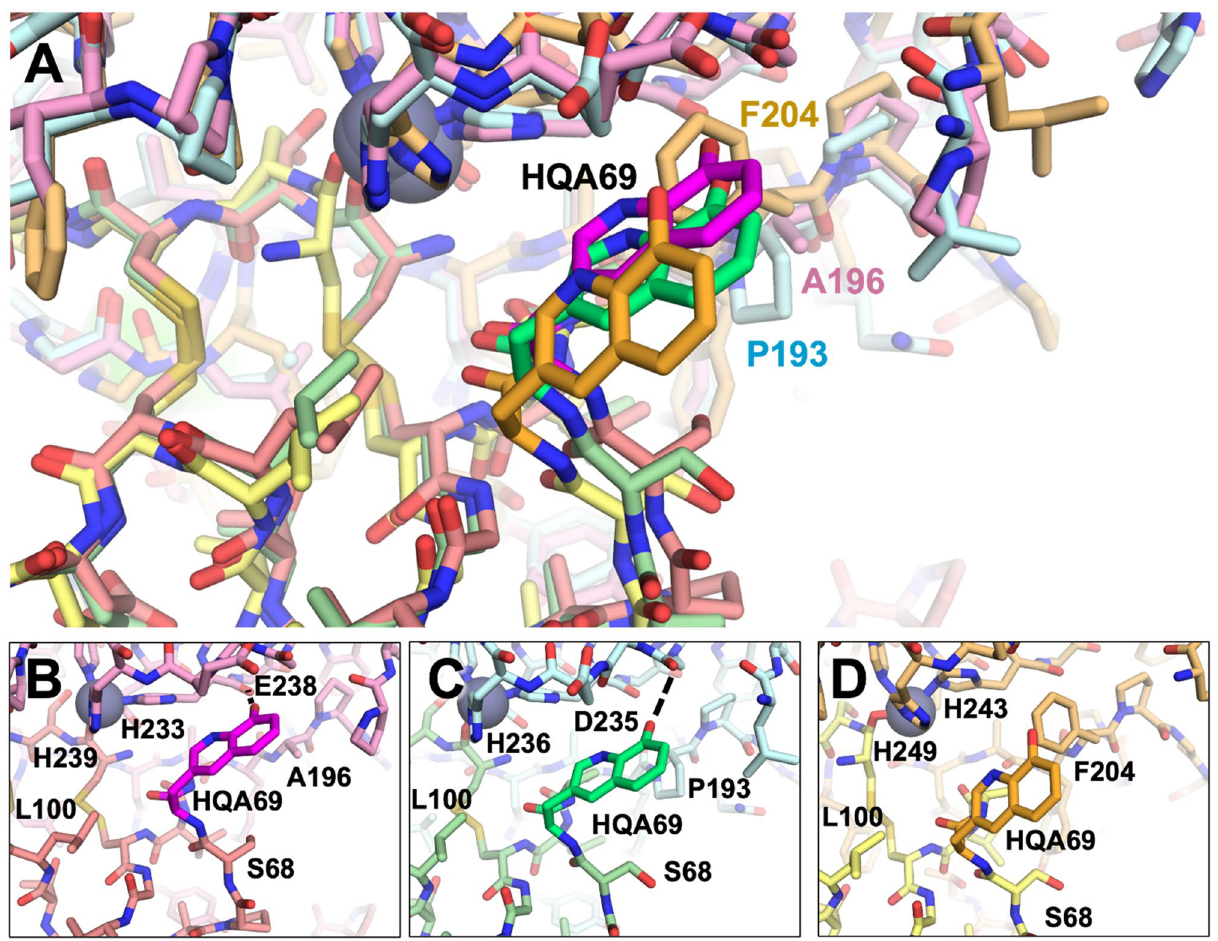
Figure 7. Structural comparison of MMP/N-TIMP2-S69HqAla complexes. ( A ) Superpositions of the modeled complexes of N-TIMP2-S69HqAla bound to each of the three MMPs are shown, with MMP-2/N-TIMP2- S69HqAla in pink/salmon, MMP-9/N-TIMP2-S69HqAla in pale cyan/pale green, and MMP-14/N-TIMP2- S69HqAla in yellow orange/pale yellow. The MMP catalytic Zn 2+ is shown as a gray sphere. ( B – D ) The local environment surrounding HqAla is shown for the complex with MMP-2 ( B ), MMP-9 ( C ), or MMP-14 ( D ). HqAla is represented in magenta, lime, and orange, respectively, with potential H-bonds indicated with black dashed lines. HqAla appears to interact more closely with MMP-2 and MMP-9, whereas a steric clash with Phe204 precludes close interaction with